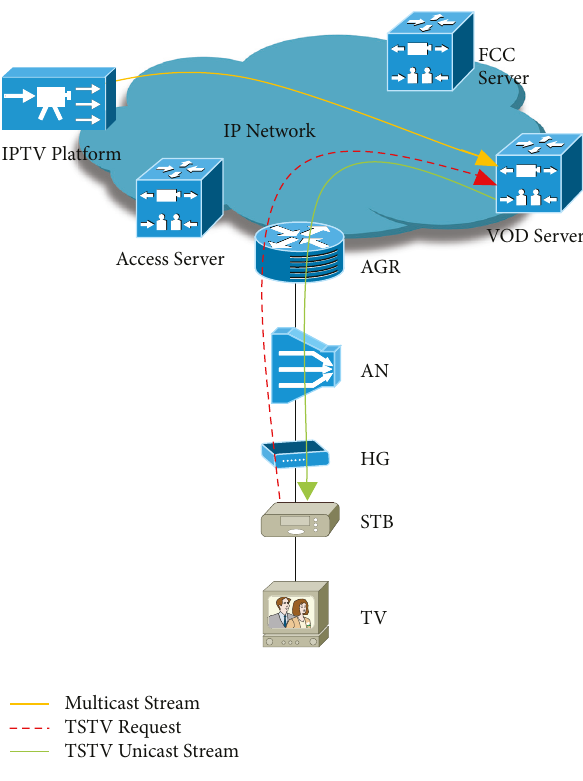
Figure 4: Working principle of TSTV